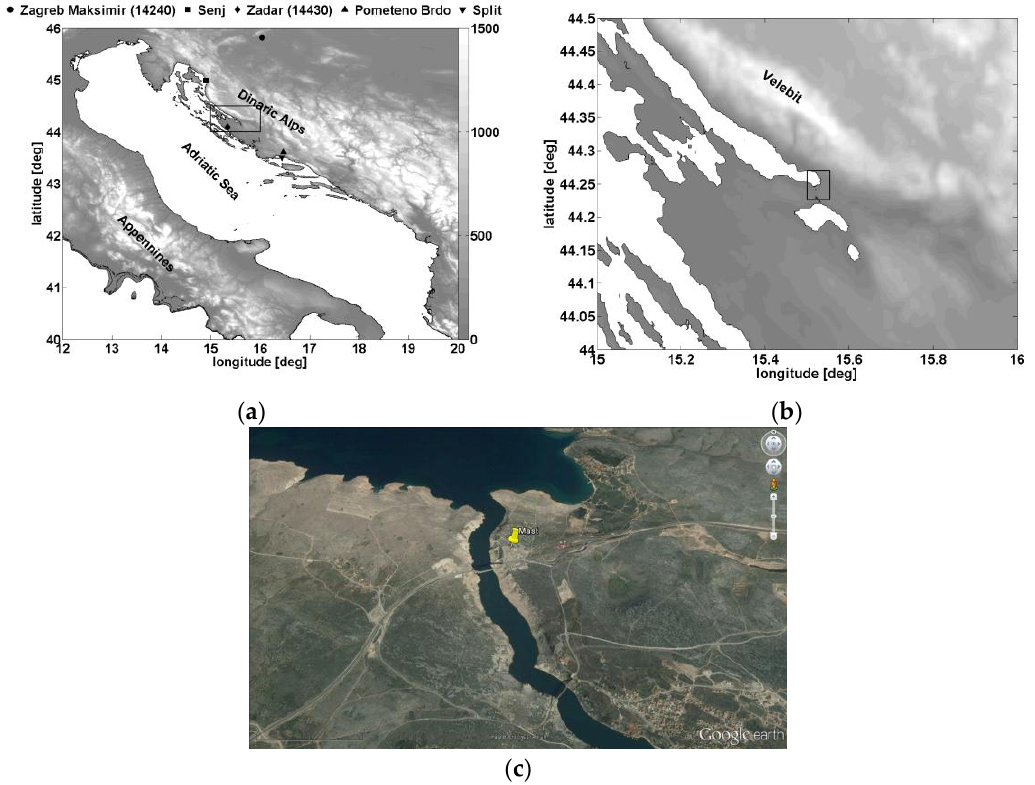
Figure 1. ( a ) The Adriatic coast with locations of previous bora studies marked (Senj and Pometeno Brdo near the city of Split). The Zadar and Zagreb Maksimir sounding stations are also marked. The box represents the area of this study. ( b ) shows the zoomed in view of that area, while ( c ) shows the zoomed in view of the measurement site at the Maslenica Bridge (shown as the box in b ). The Velebit Mountain is mostly north of the site.